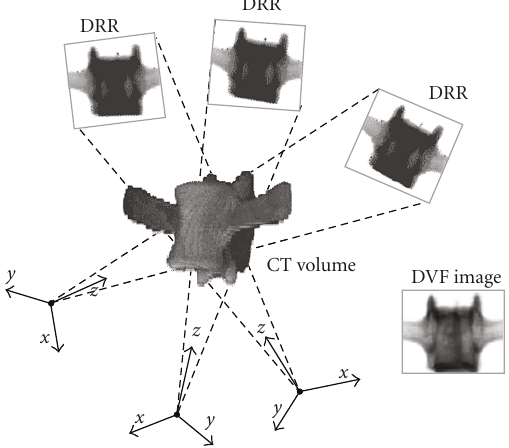
Figure 1: General sketch of the proposed method. A 3D CT vertebra model is available (the vertebra’s 3D rendering is shown at centre). A DRR can be reconstructed from any orientation and distance. DRRs can be matched with a real DVF radiographic projection using a similarity index. The DRR that maximises the similarity with the real image is searched for. This procedure provides the vertebral 3D pose